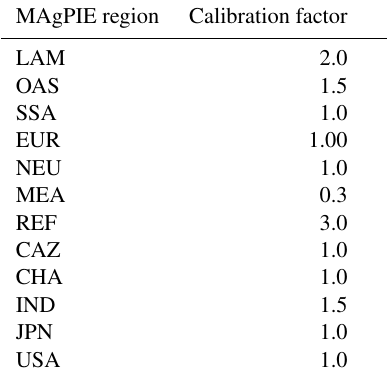
Table A5. Calibration factor for establishment